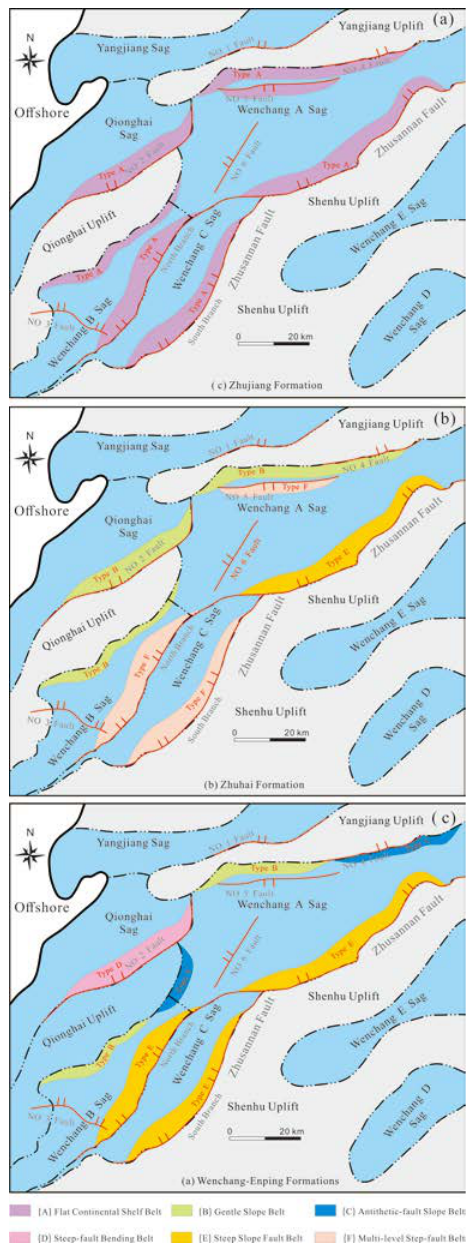
Figure 11. The spatial distributions of slope break belts of the Zhujiang Formation ( a ), Zhuhai Formation ( b ), and Wenchang-Enping Formations ( c ) in the Zhu III Depression, PRMB.